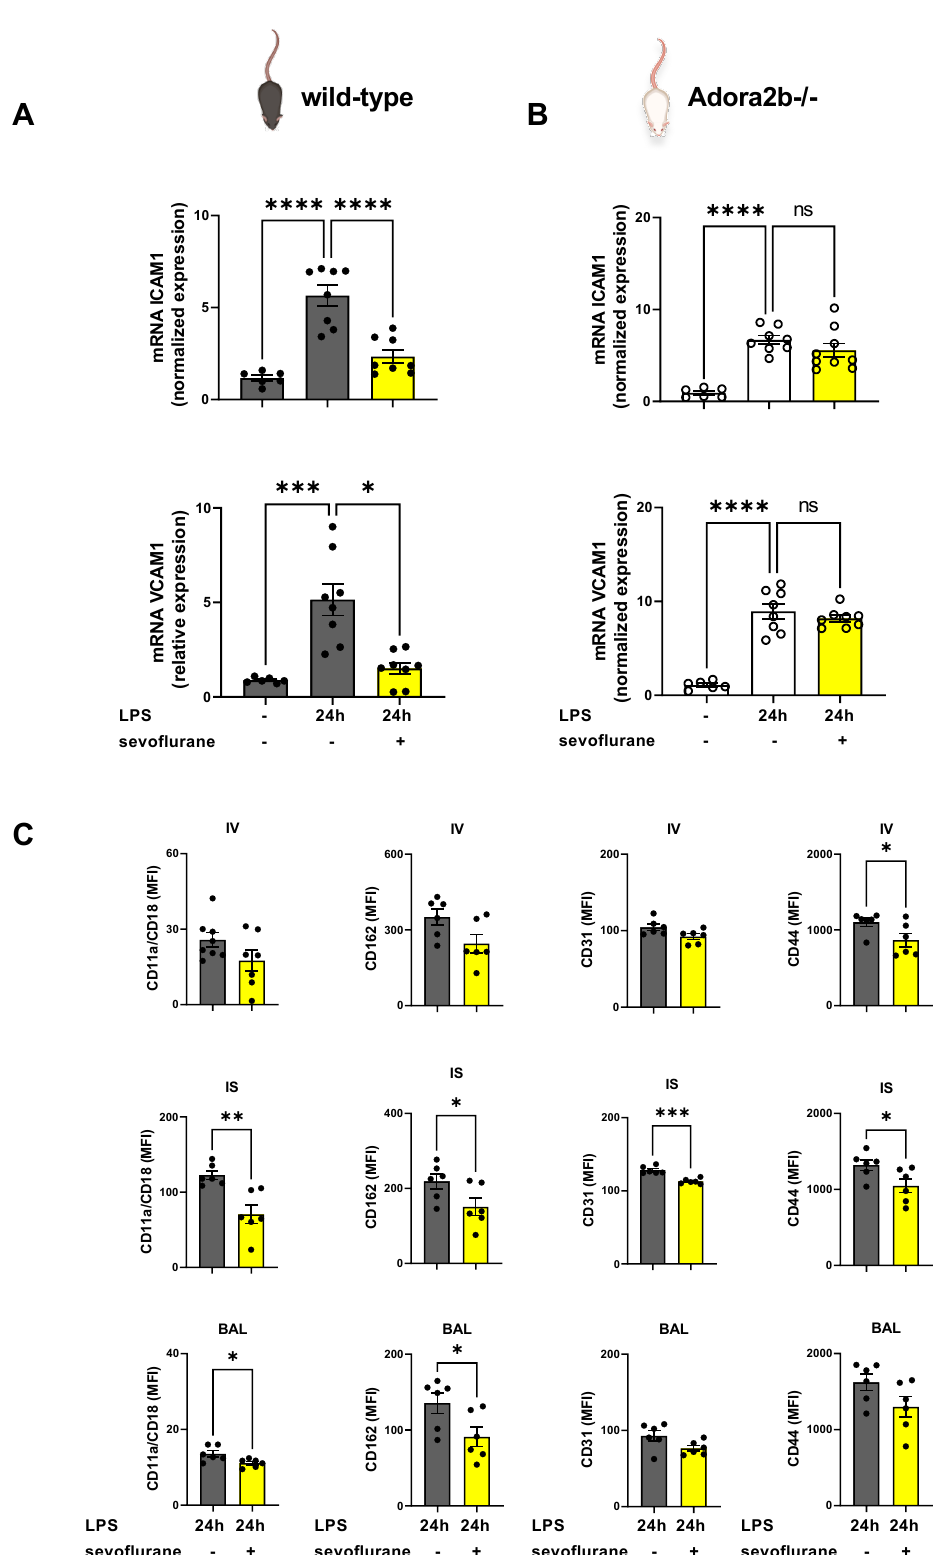
Figure 3. Influence of sevoflurane on the expression of adhesion molecules in the lung tissue and on neutrophils. ( A ) Wild-type, and ( B ) adenosine A2B receptor − / − (Adora2b − / − ) mice were treated with lipopolysaccharide (LPS) and sevoflurane, and the gene expression of intercellular adhesion molecule 1 (ICAM1) and vascular cell adhesion molecule 1 (VCAM1) in the pulmonary tissue